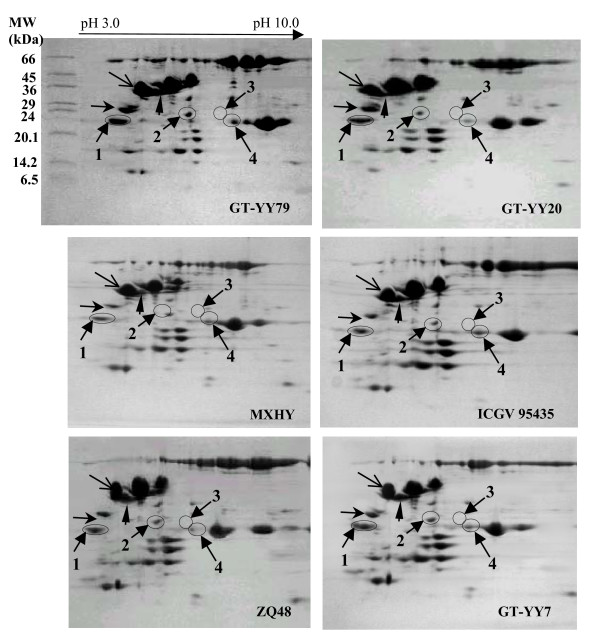
2-D SDS-PAGE peanut seed total protein profiles. Two-dimensional SDS-PAGE of peanut seed total protein profiles of 6 cultivated peanut genotypes, Spanish market type. Gels are oriented with the acid end of the isoelectric focusing separating to left and the basic end to the right. The arrow () indicates the protein band with a molecular weight of 35 kDa and the arrow () indicates the 27 kDa protein band (Fig. 1). The arrow head () indicates the fourth band as reported for Spanish cultivars [9]. The numbered arrows () pointing to cycled spots indicate the polymorphic polypeptide spots, which were sequenced (Table 2).